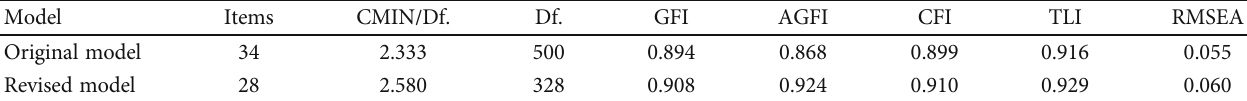
Table 10: Model fi t summary (original and revised model indices).